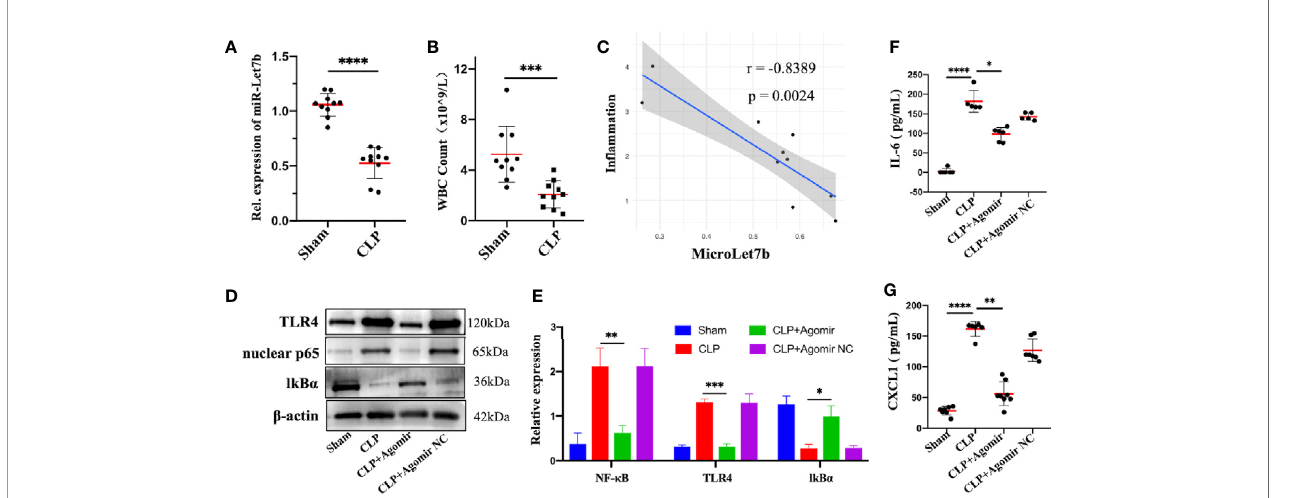
FIGURE 4 | Overexpression of miR-let-7b suppresses neutrophilic in fl ammation in vivo . (A) Expression of miR-let-7b in sham and CLP-induced septic mice from the peripheral blood using RT-qPCR (n=10, ****P < 0.0001). (B) Total WBC count in sham and CLP-induced septic mice from the peripheral blood (***P < 0.001). (C) Correlation analysis between the level of miR-let-7b and the degree of septic in fl ammation (r=-0.8389, p=0.0024). (D, E) Effects of miR-let-7b agomir and its NC on neutrophilic TLR4, nuclear NF- k B p65 and IkB expression in CLP-induced septic mice were assessed by western blotting. *P < 0.05, **P < 0.01, ***P < 0.001. (F, G) Serum levels of IL-6 (F) and CXCL1 (G) were measured by ELISA in mice (n = 5-8 mice per group, *P < 0.05, **P < 0.01, ****P <